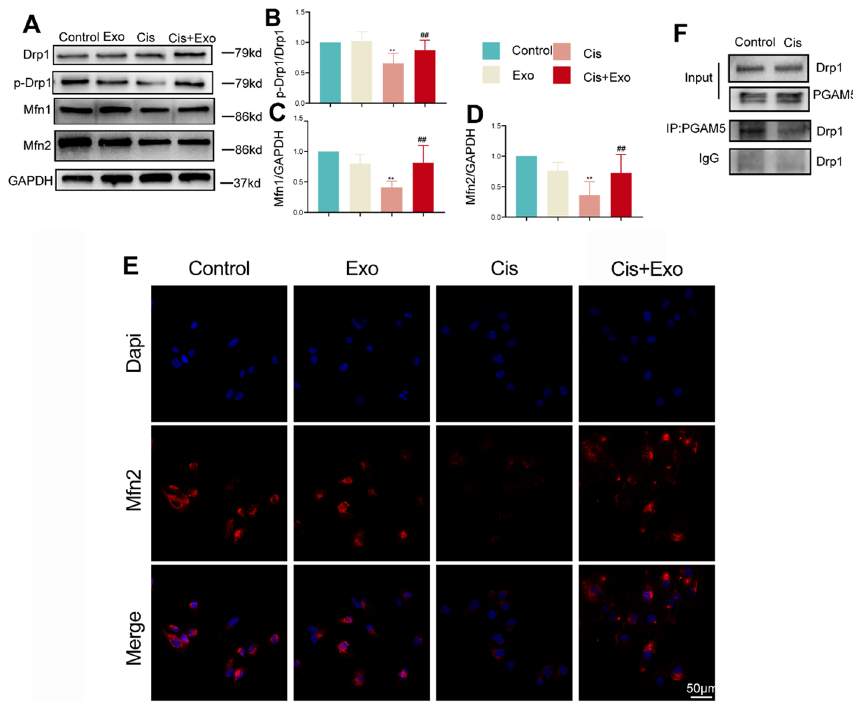
Fig. 6 Examination of mitochondrially related markers in four groups in vitro. A Western blot of mitochondrial fusion-related markers (Drp1, p-Drp1, Mfn1, and Mfn2) in each group. B – D Relative expression of mitochondrial fusion-related markers detected by western blot. * p < 0.05, ** p < 0.01, compared with control group; # p < 0.05, ## p < 0.01, compared with cisplatin (Cis) group. E Immunohistochemistry of Mfn2 in each group. F Co-immunoprecipitation assays detecting Drp1 and PGAM5 interaction in HK-2